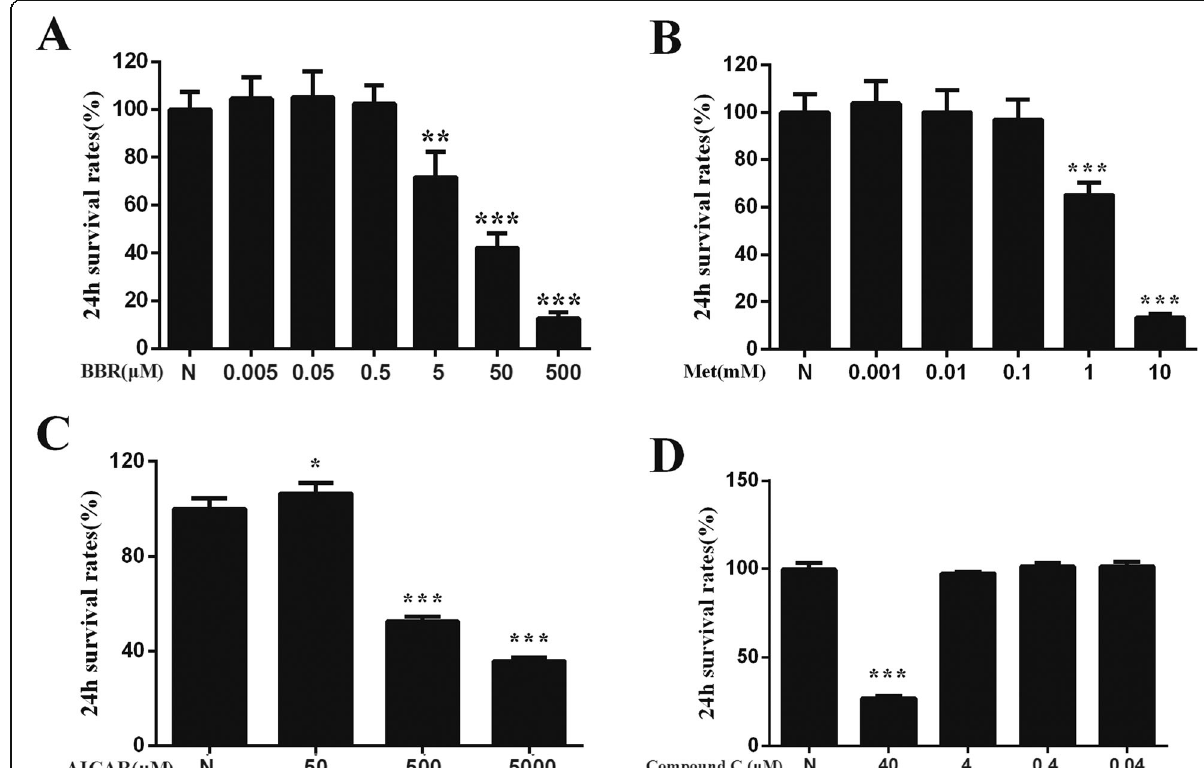
Fig. 1 Effects of intervention agents on the survival rate of Raw264.7 cells. a BBR, berberine. b Met, metformin. c AICAR. d Compound C. N,